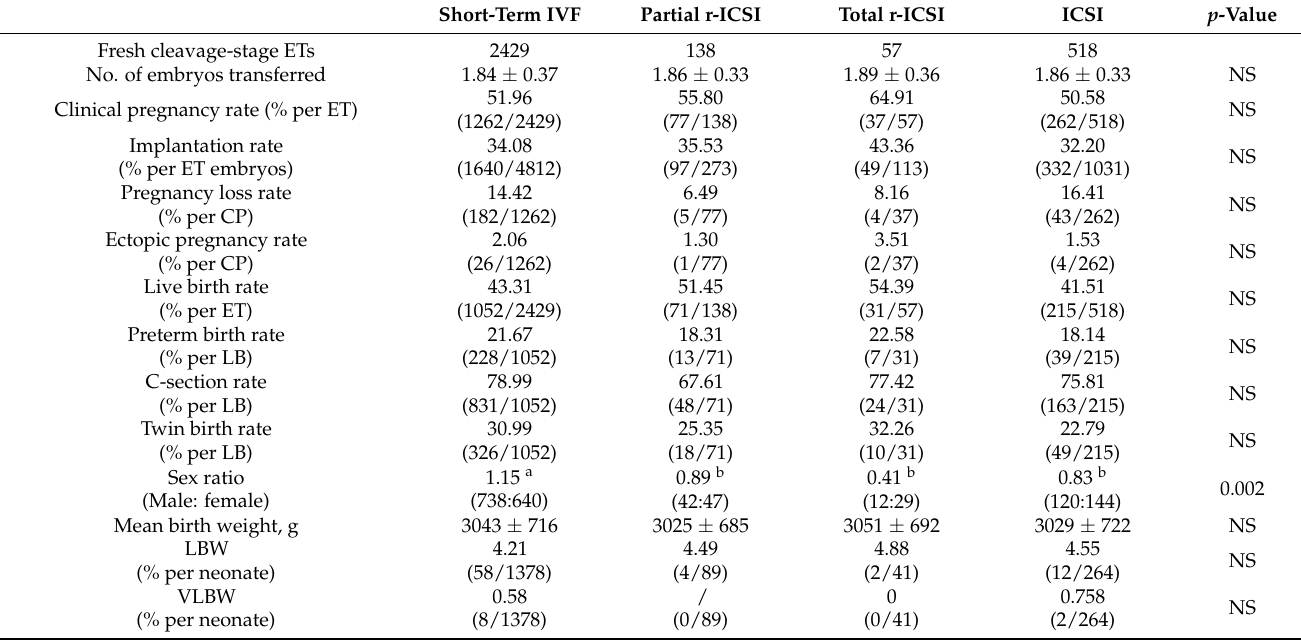
Table 3. Pregnancy, delivery, and neonatal outcomes among four groups in fresh cleavage-stage ET cycles.